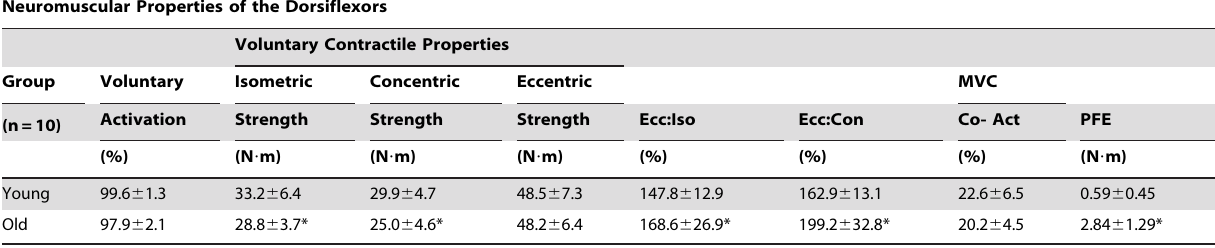
Neuromuscular Properties of the Dorsiflexors